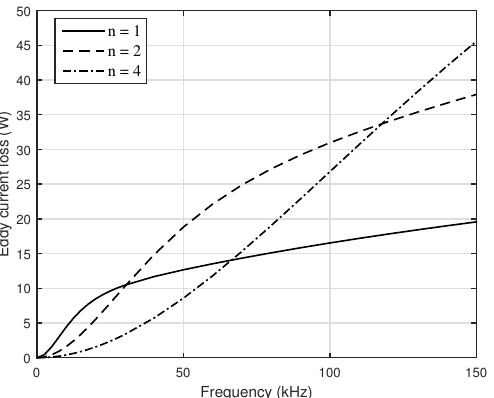
Figure 9. Magnet eddy current losses vs. frequency for different circumferential